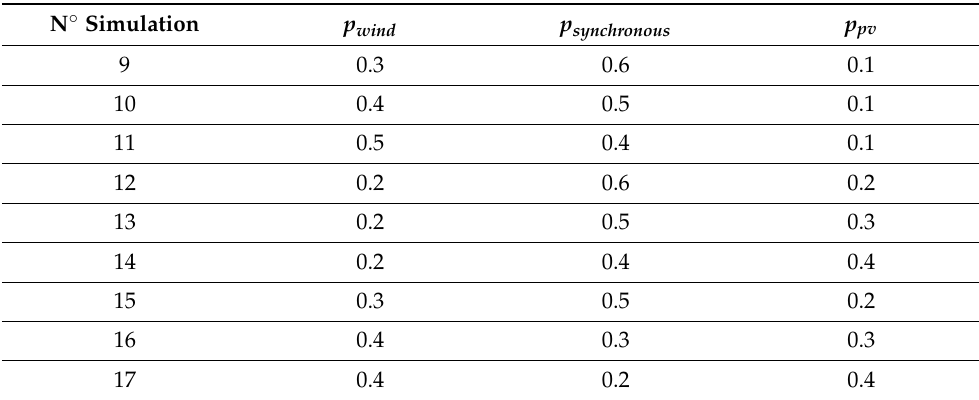
Table 4. Summary of Simulation